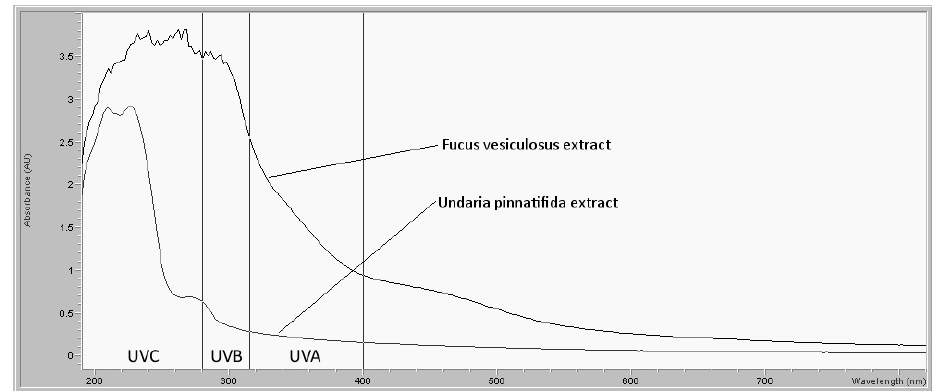
Figure 1. Ultraviolet (UV)-Vis absorbance spectra of macroalgal extracts at 0.1% w / v .